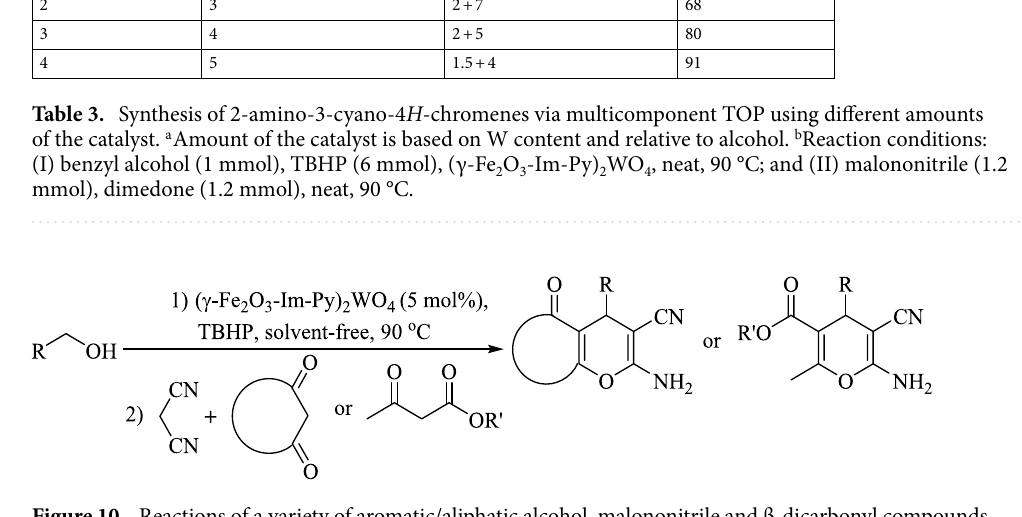
Figure 10. Reactions of a variety of aromatic/aliphatic alcohol, malononitrile and β-dicarbonyl